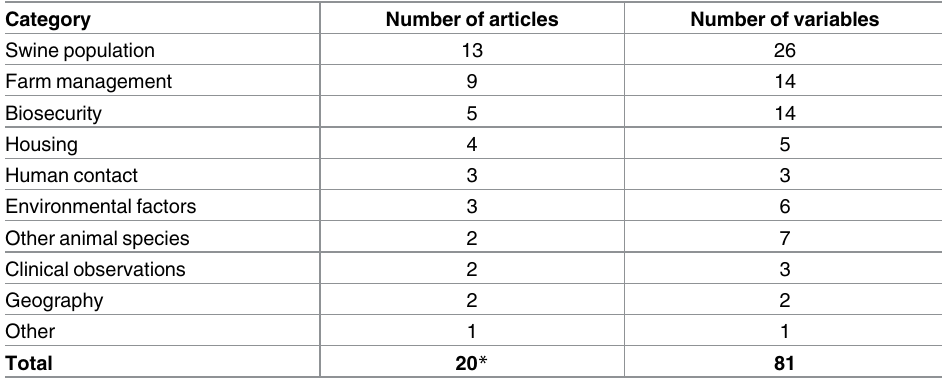
Table 7. Categories of variables significantly associated with influenza